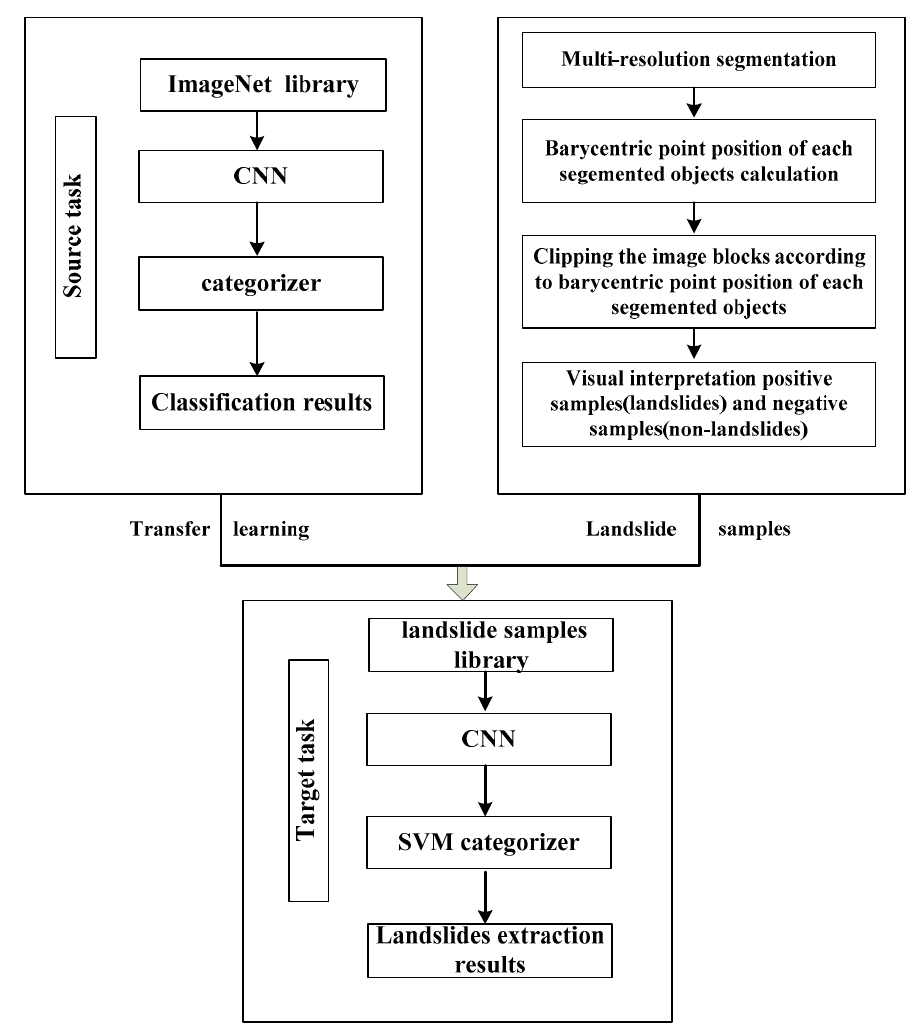
Figure 8. The flow chart of landslides extraction by the transfer learning model and object-oriented image analysis (TLOEL) method.